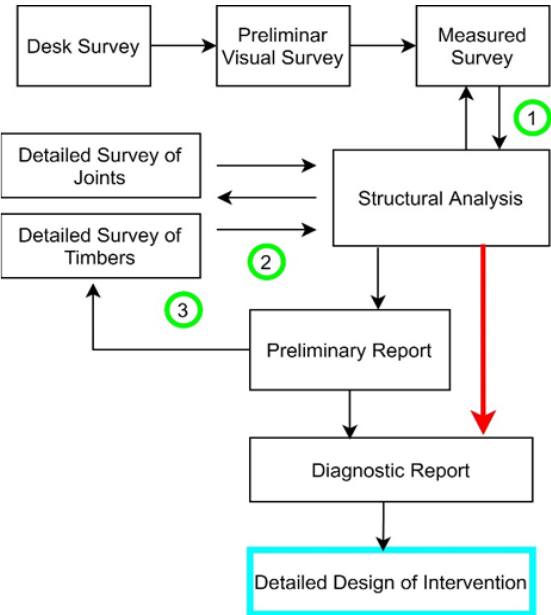
Figure 10. European Cooperation in Science and Technology ( COST) action flowchart for vulnerability assessment and conservation of historic timber buildings. Adopted from [20].